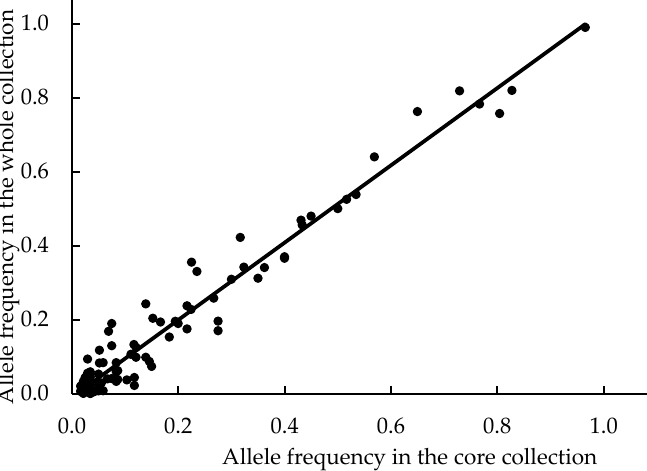
Figure 6. Correlation between the allele frequencies of 93 SSR alleles in the core collection (30 individuals) and the breeding parents (343 individuals).